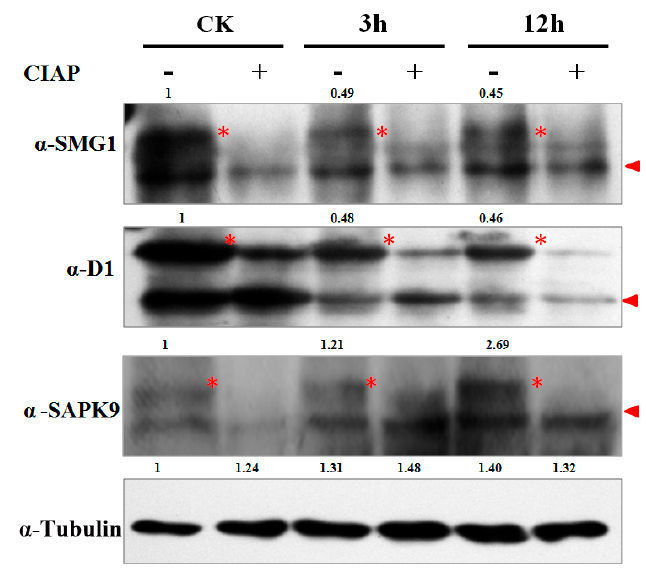
Figure 5. Western-blot analysis of SMG1, D1 and SAPK9 to verify the Mass Spectrometry (MS)-identified phosphorylation pattern at CK, 3 and 12 h. Red triangle indicates the target band in original size; Red asterisk indicates the phosphorylated target protein band. Anti-tubulin was used as an internal control for normalization. The values above the phosphorylated bands represent the normalized, relative band intensities by setting CK to 1.